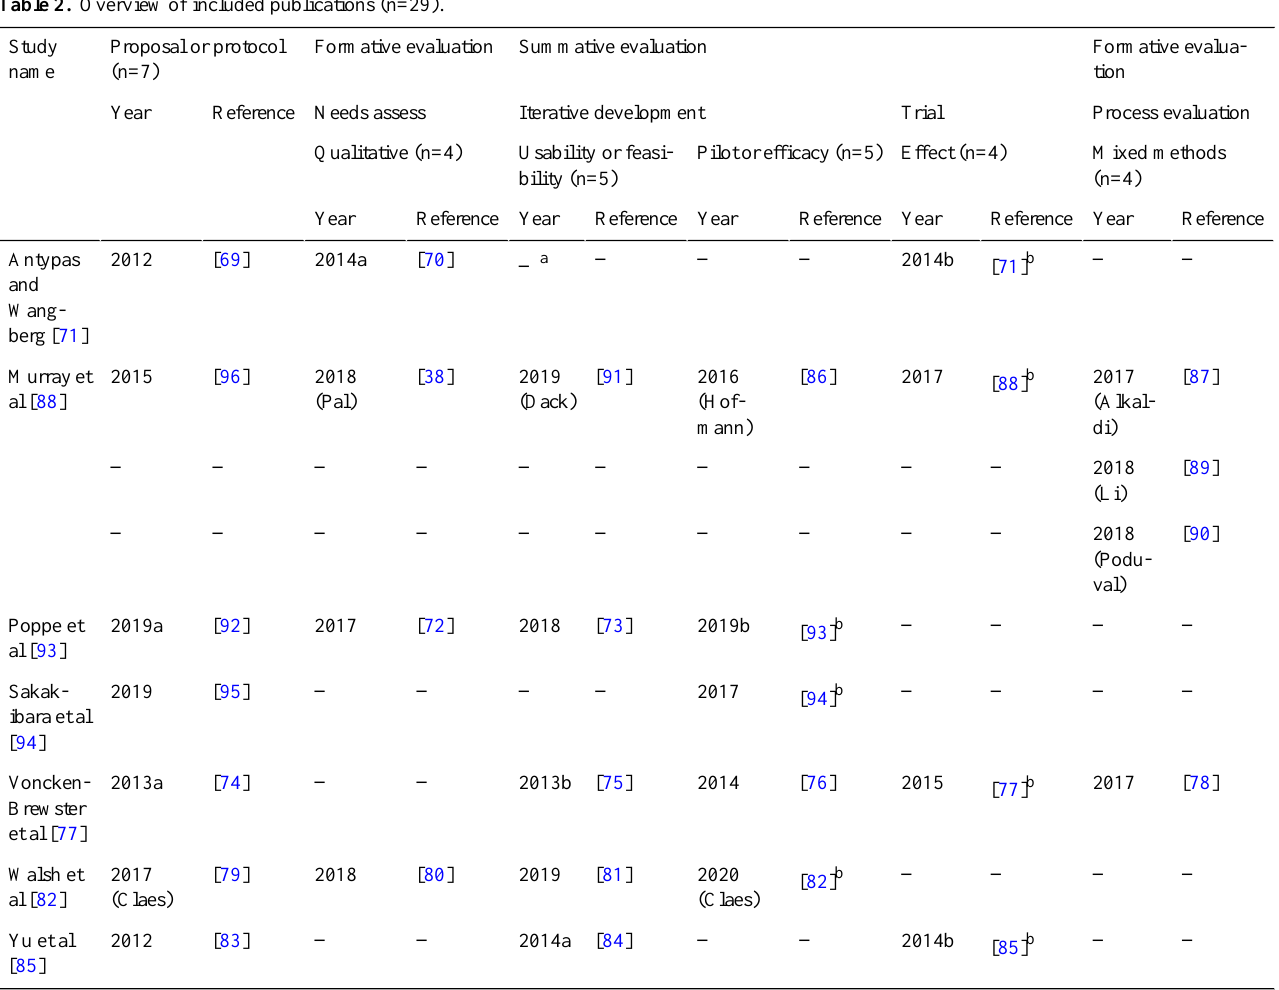
Table 2. Overview of included publications